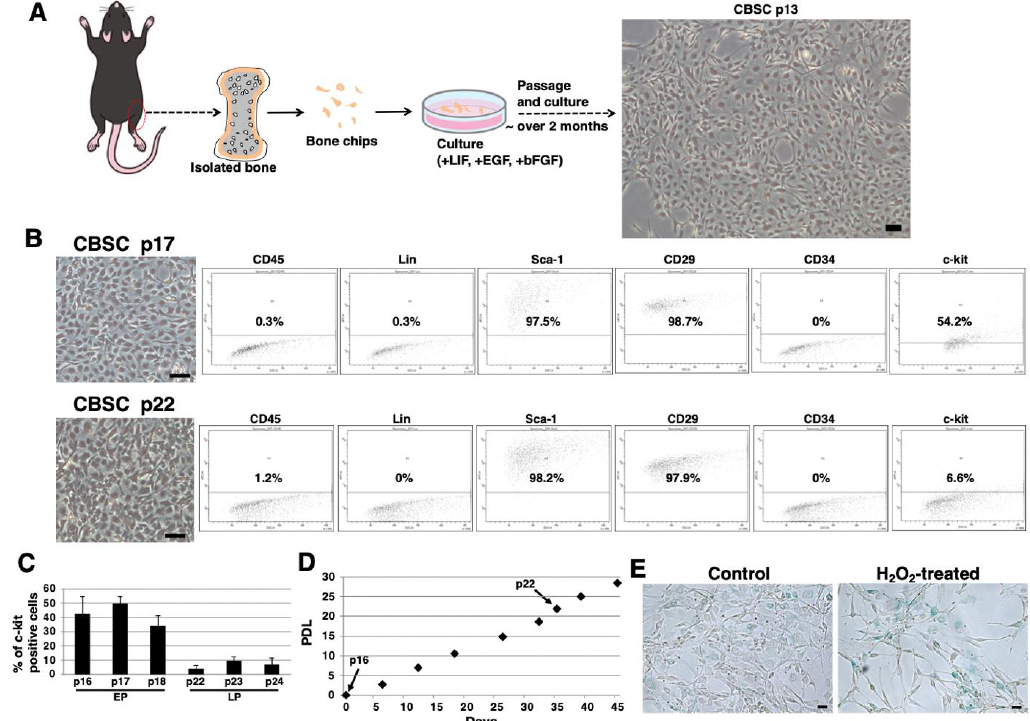
Figure 1. Isolation of mCBSCs. ( A ) Scheme of isolation and culture of mCBSCs. The bone biopsy was isolated from one limb. Then, bone chips were prepared and cultured with mCBSCs culture media. About 2 months after passage and culture, mCBSCs was observed. Scale bar in the phase contrast image: 2 µ m. ( B ) FACS analysis of CD45, Lin, Sca-1, CD29, CD34, and c-kit in mCBSCs (p17 and p22). Three independent experiments were performed and representative results are shown. Scale bar in the phase contrast image: 2 µm. ( C ) Percent of c-kit positive cells in mCBSCs (p16-p18 and p22-p24) is shown. The values shown are the means ± SD from three independent experiments. ( D ) Growth curve showing the population doubling level (PDL) during culturing from p16 to p24. ( E ) Representative image of staining for SA- β -Gal in nontreated (control) or 400 µM hydrogen peroxide (H 2 O 2 ) - treated LP-mCBSCs from two independent experiments is shown. Scale bar in the phase contrast image: 50 µm. Abbreviations: mCBSC, mouse cortical-bone-derived stem cell; EP, early passage; LP, late passage; PDL, population doubling level; SA- β -Gal, senescence-associated β -galactosidase; H 2 O 2 , hydrogen peroxide.